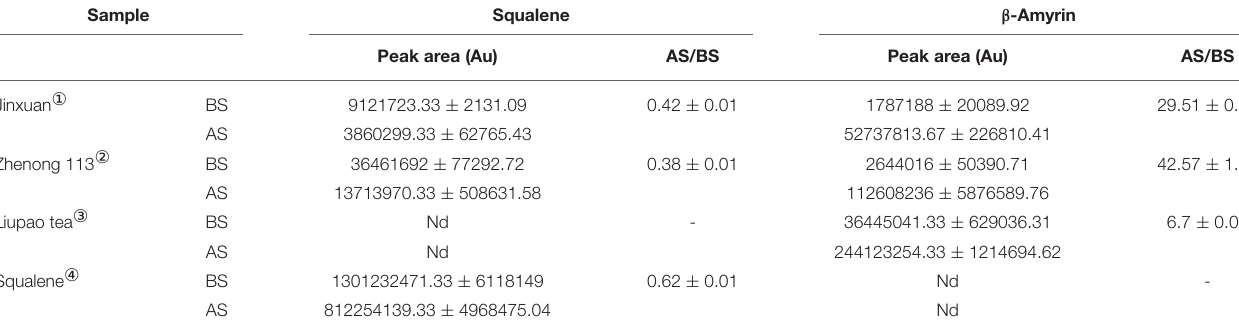
TABLE 1 | Effects of saponification on contents of squalene and β -amyrin (mean ± SD).